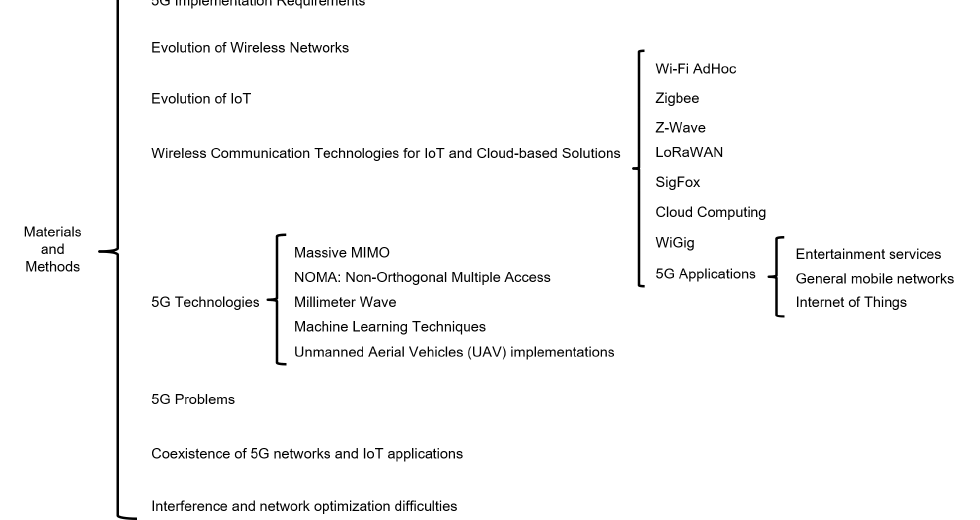
Figure 4. Materials and Methods for 5G and IoT